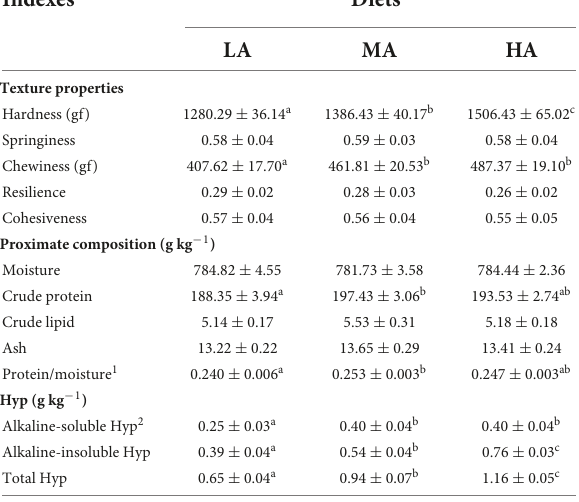
TABLE 2 The muscular textural properties, proximate composition, and collagen contents of L. vannamei after dietary arginine treatment for 56 days.